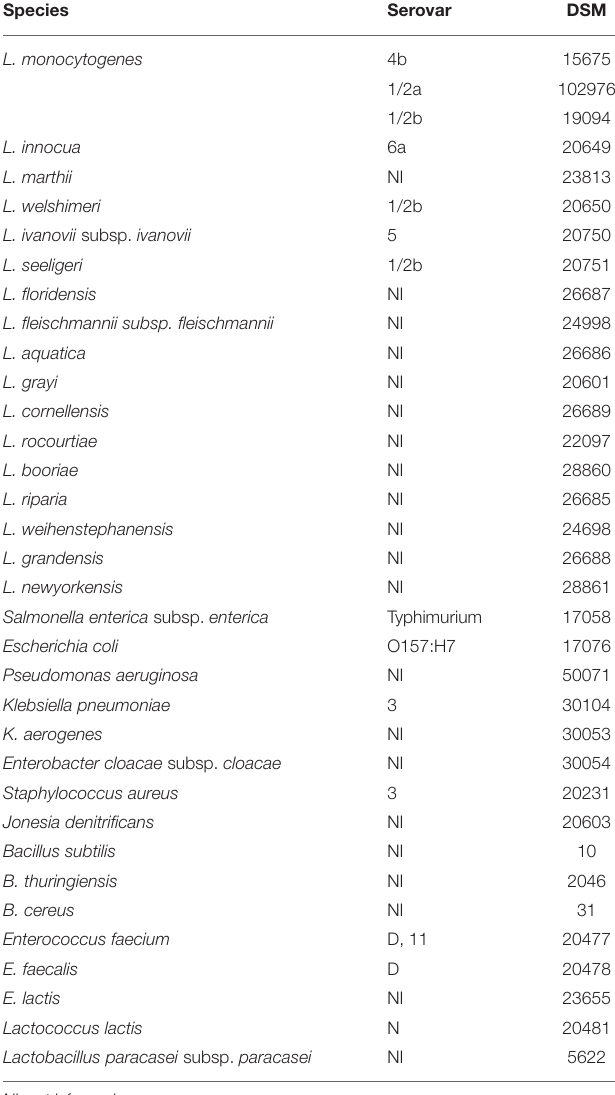
TABLE 1 | List of the Listeria and non- Listeria species used in indirect ELISA for diagnostic performance assessment. Species